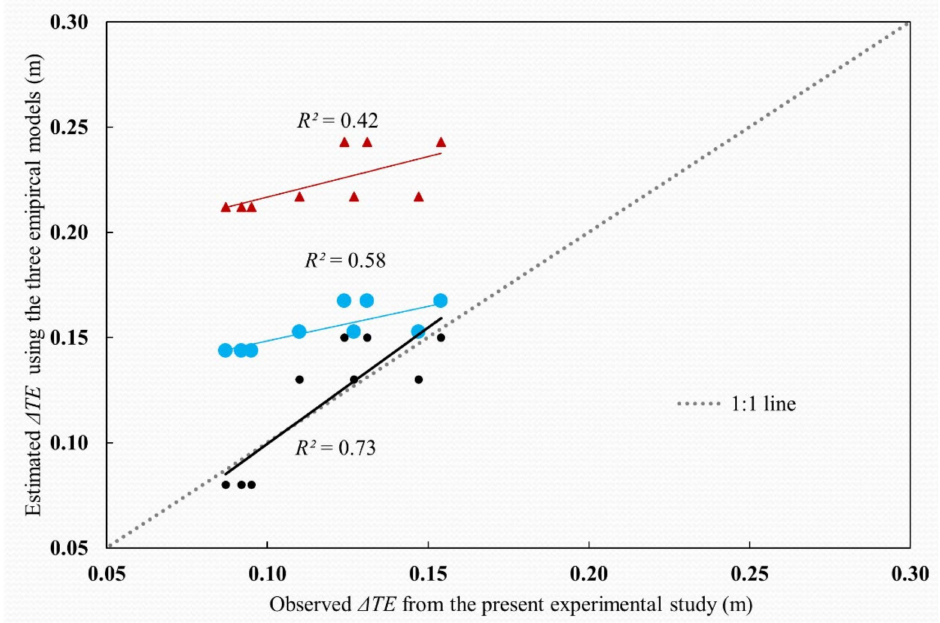
Figure 6. Comparison of observed and estimated total head